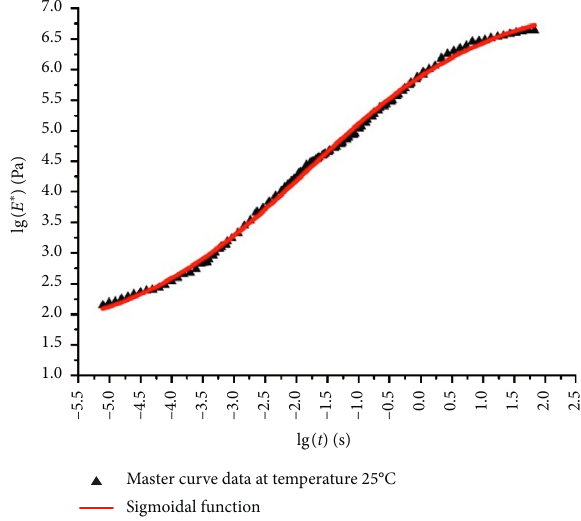
Figure 8: Fitting of the sigmoidal function. Table 2: Prony series constants computed for the shear modulus.